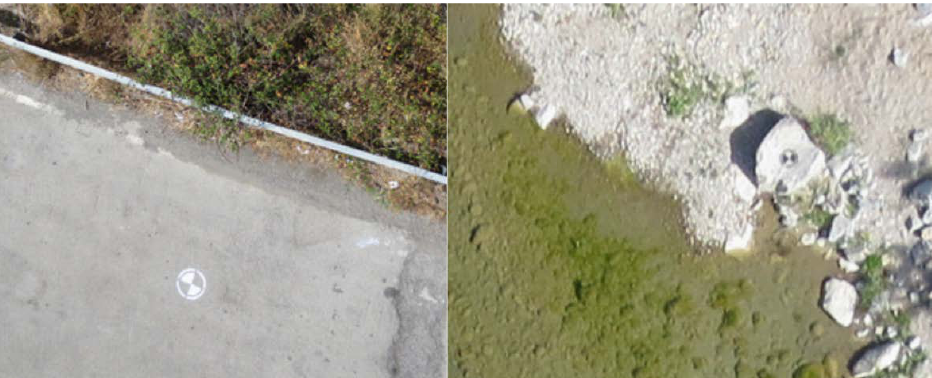
Figure 3. Example of two markers used for the GPS coordinates of the ground control points (GCPs). Table 1. Characteristics of the UAV photogrammetric surveys.